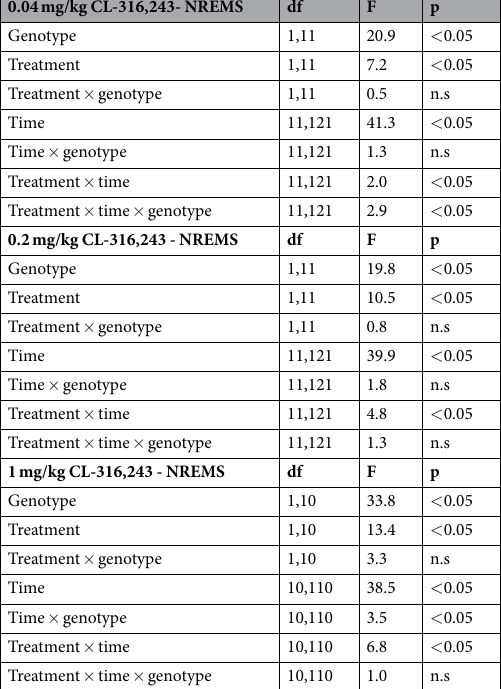
Table 1. Effects of CL-316,243 on NREMS in WT and UCP-1 KO mice – statistical